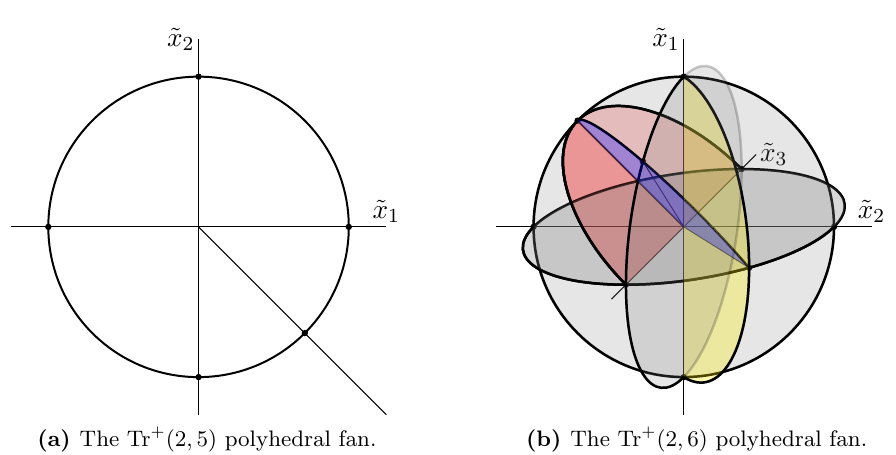
Figure 5 . The intersection of the Tr + (2 ; n ) fan with the unit sphere S n (cid:0) 4 gives the dual of the Gr(2 ; n ) associahedron. Notice the Tr + (2 ; 5) subfan on the (~ x 1 ; ~ x 2 ) plane of Tr + (2 ;